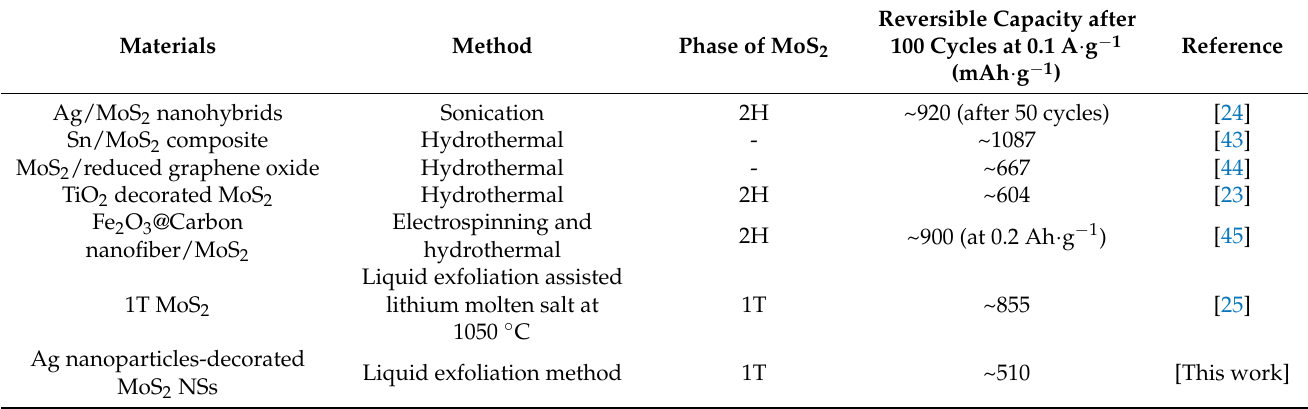
Table 1. Recent research of MoS 2 nanosheets (NSs) for Li-ion storage.